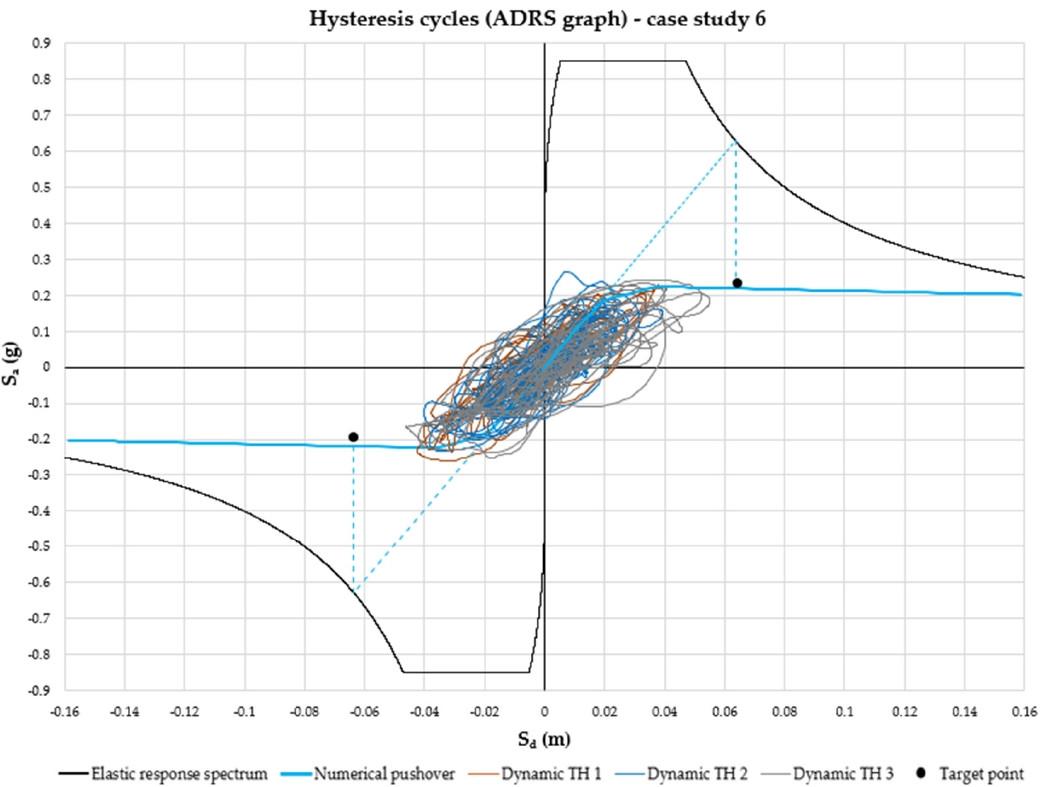
Figure 20. Hysteresis cycles obtained from the dynamic time-history analysis for case study 6.